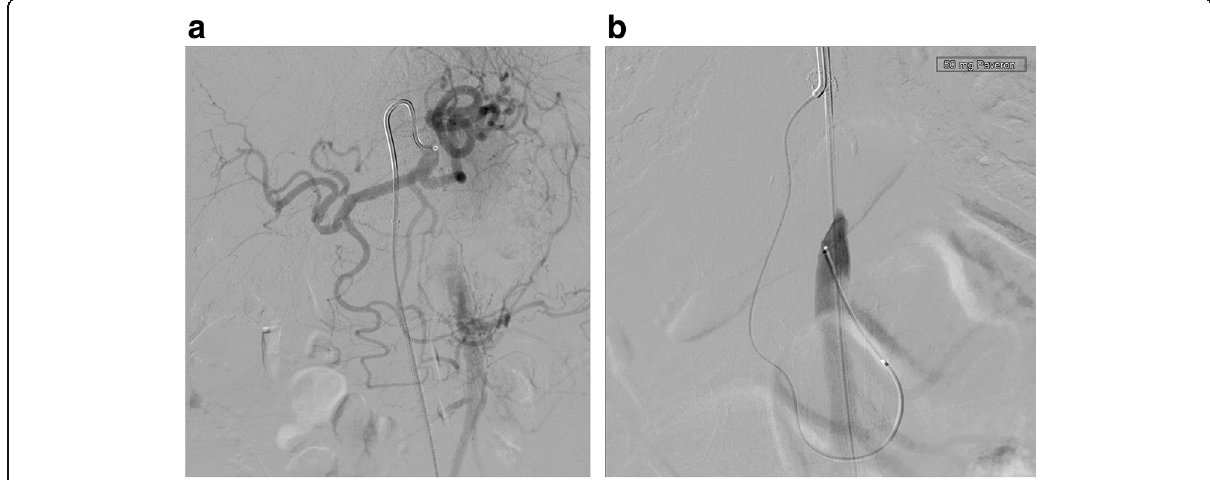
Fig. 2 Same patient as in Fig. 1. a Selective angiography of the celiac artery with a Sidewinder I-catheter. b After passage of the gastroduodenal artery and the pancreaticoduodenal arcade with a coaxially inserted microcatheter the SMA is retrogradely filled up to the proximal occlusion